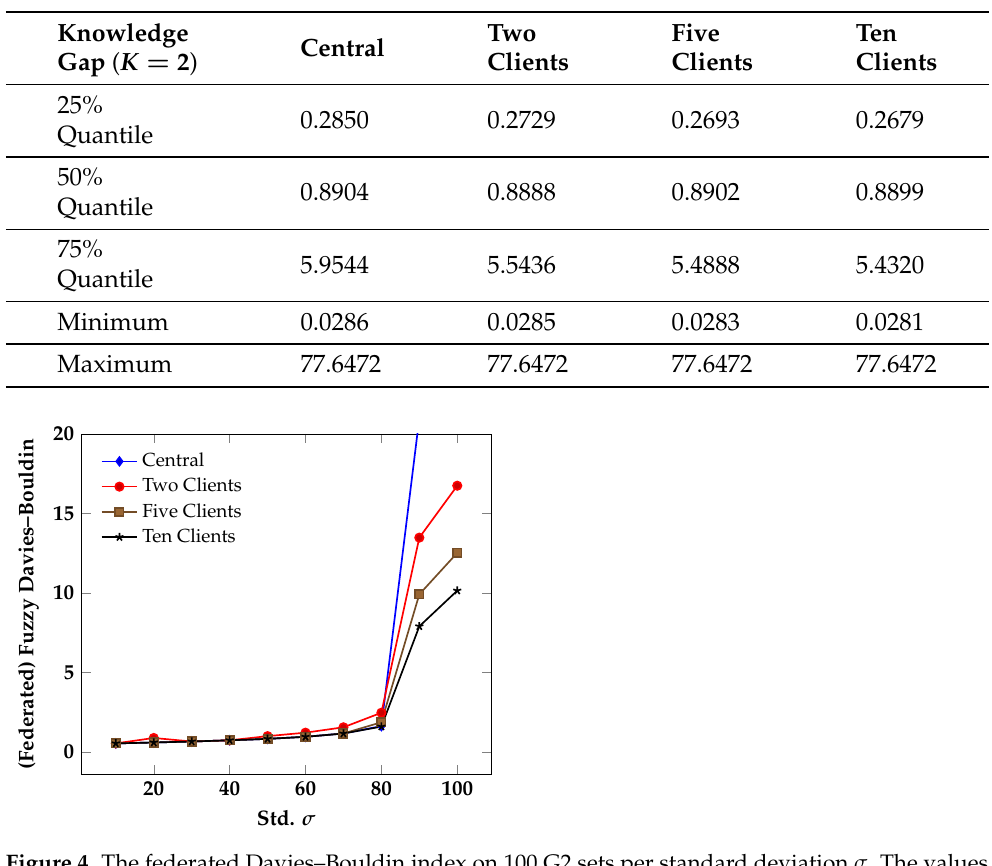
Figure 4. The federated Davies–Bouldin index on 100 G2 sets per standard deviation σ . The values are averaged over all values of D and runs. As expected, we see an increasing index with higher σ . However, the index suggests that it is hard to find good clusterings with FedFCM for σ ≥ 80. The values outside this plot are 434.4732 and 2463.9748